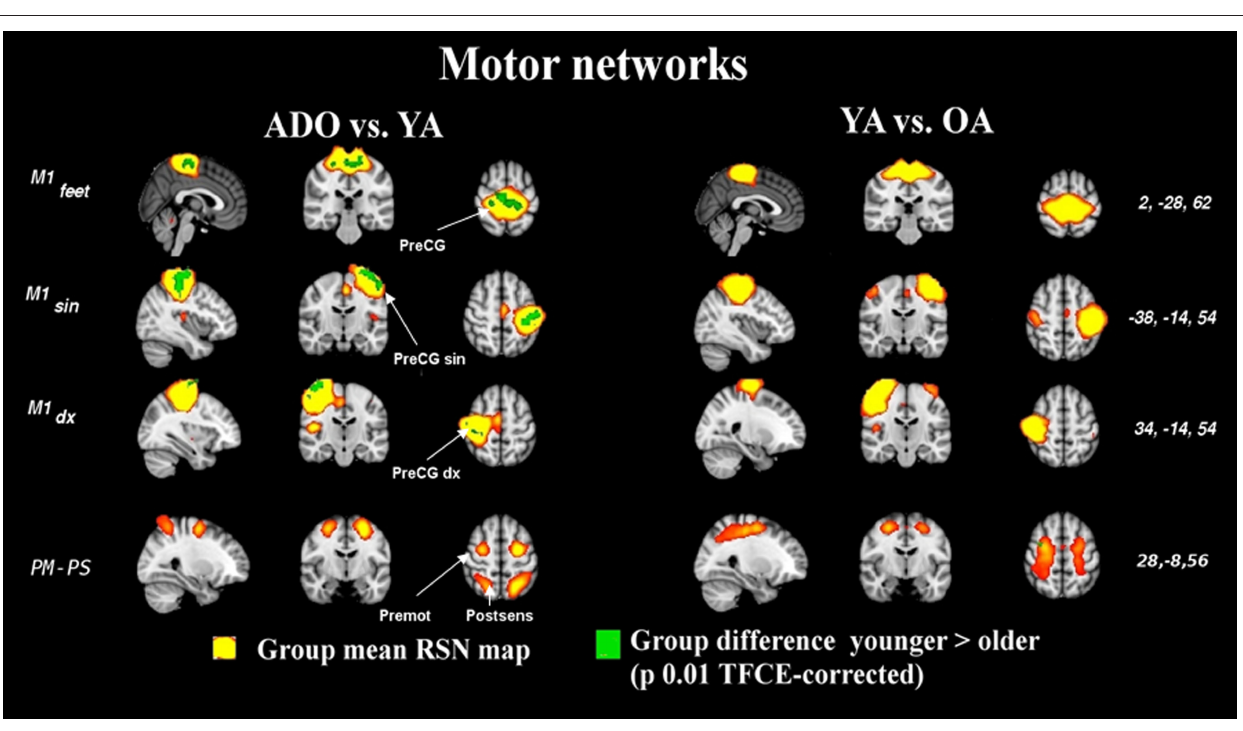
Figure 4 | The image parameters and thresholding are the same as in Figure 1. Notably, the changes occur at a young age. The quadrate PM–PS RSN looses integrity in older adulthood altogether, c.f. Figure S2 in supplementary material. CG, central gyrus, premot, pre-motor cortex, post sens, dorsal to somatosensory